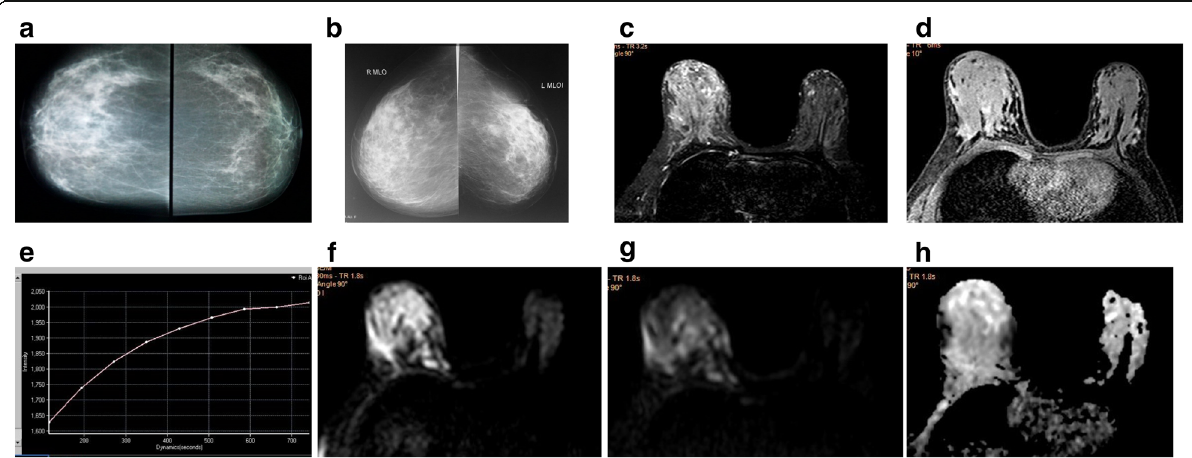
Fig. 8 A 37-year-old female patient with right mastalgia and breast tenderness for 3 weeks, not relieved with antibiotic therapy. Mammography craniocaudal ( a ) and mediolateral oblique ( b ) views show global asymmetry in the right breast (BIRADS II lesion). Axial STIR ( c ) is showing diffuse increased the signal intensity of the right breast parenchyma. Axial TI contrast-enhanced fat-suppressed image on dynamic sequence ( d ) shows diffuse homogenous non-mass enhancement of the right breast. Dynamic time-intensity curve ( e ) shows type I “ progressive enhancement ” curve. The lesion shows high signal on DWI at b value = 200 ( f ) and a very faint hyper intense signal at b value = 800 ( g ) with ADC value 1.68 × 10 – 3 mm 2 /s ( h ). MRI findings: BIRADS III lesion. Histopathological diagnosis: chronic